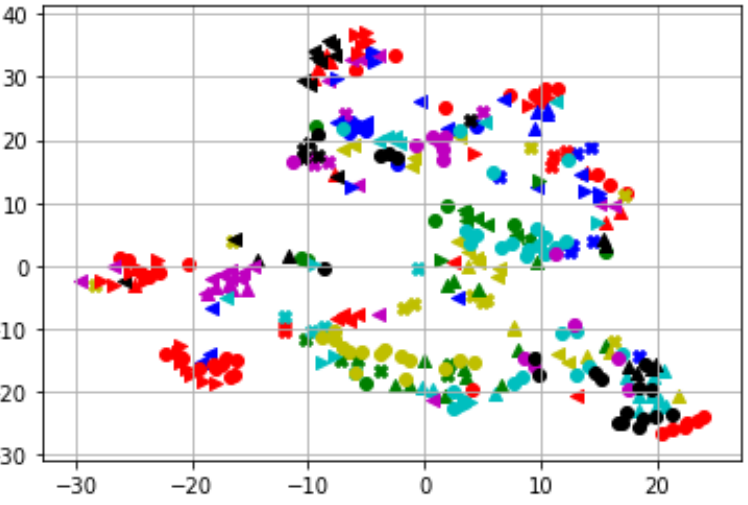
Figure 18. t-SNE feature maps of MARS. A different color and shape marker indicates a